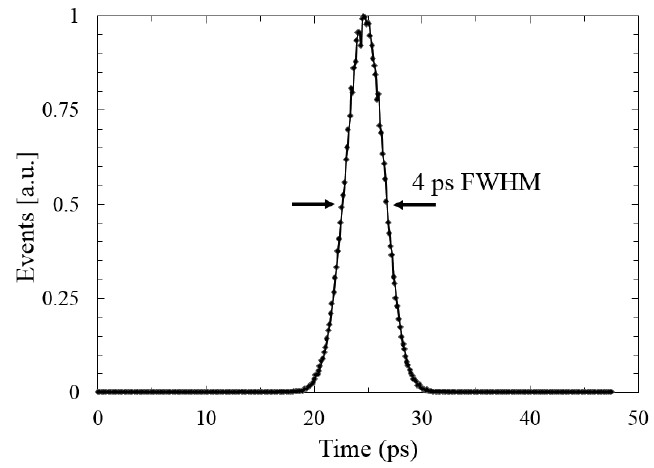
Figure 8. Histogram of the QC timing jitter in response to a 1 V step with a 200 mV threshold.